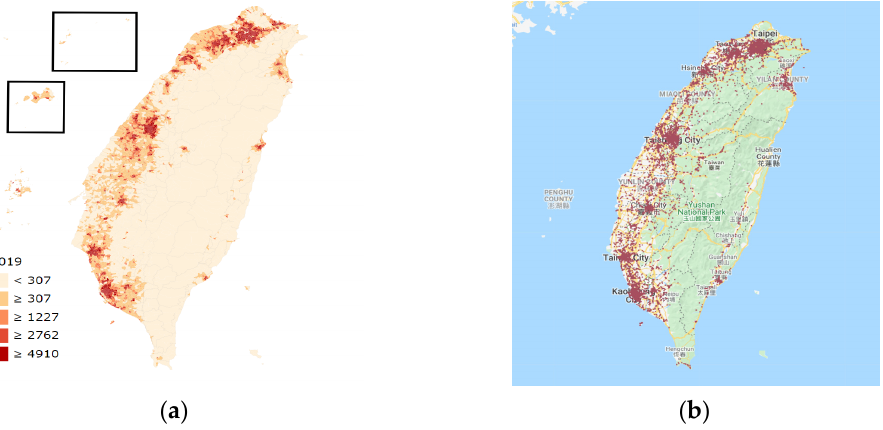
Figure 8. The simulated environment. ( a ) The distribution of residents per square kilometer by village; ( b ) the distribution of the targeted points for the simulation.